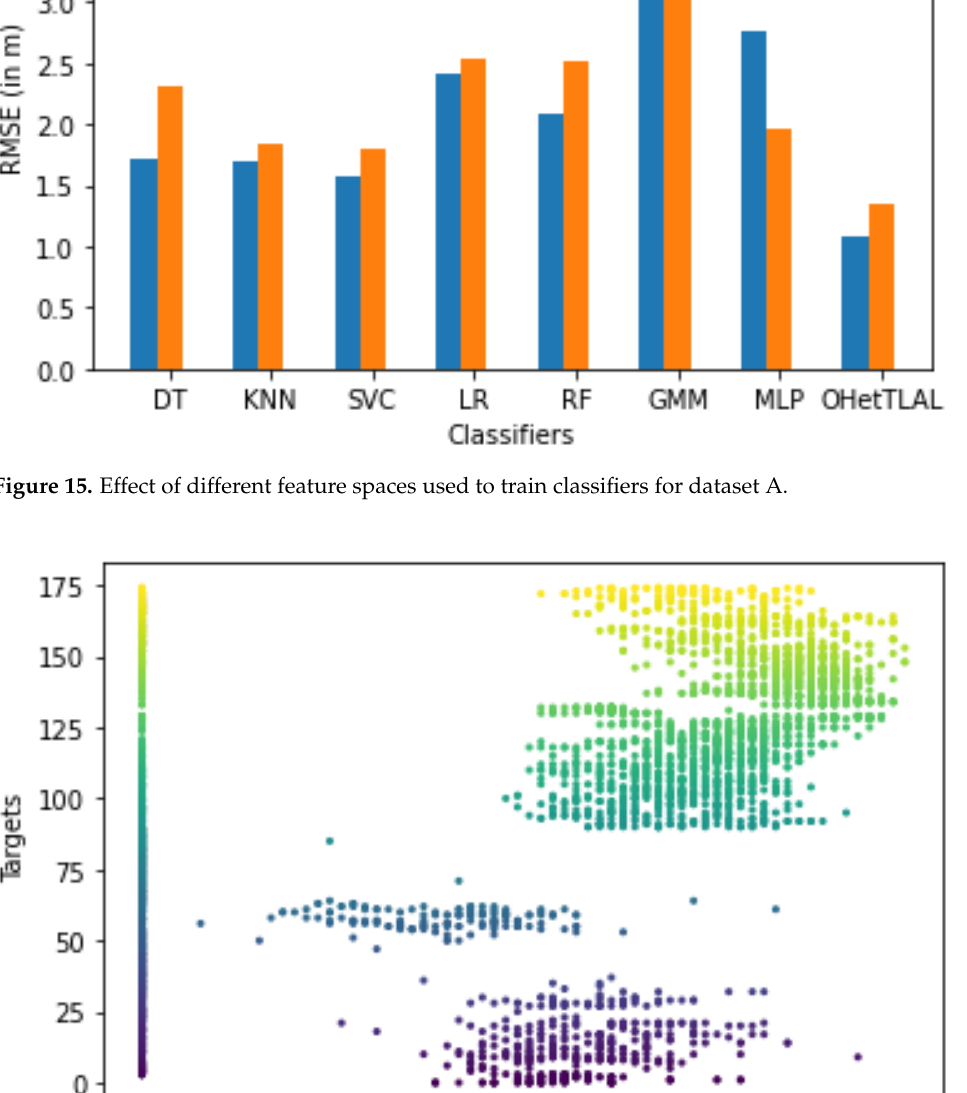
Figure 17. Distributions of RSS for Wi-Fi-AP3 with their corresponding targets for dataset B. Figure 18 shows that the RSS measurements for the different pair of access points have a certain pattern and follow the different distribution of RSS values for the different labels of an access point (dissimilarity). It is further described that the Wi-Fi signal strength received at a network point by multiple APs is assumed to be independent so that the Wi-Fi signals sent by different APs are transmitted independently and do not interfere with each other. Therefore, the distributions of RSS measurements for pairs of Wi-Fi access points demonstrate a different pattern of fingerprint for a mobile device at a given reference point even after performing transformation techniques. It can be observed that the RSS measurements for the different Wi-Fi access points of AP_3 and AP_7 have a specific pattern and follow the different distribution of RSS values for the different labels